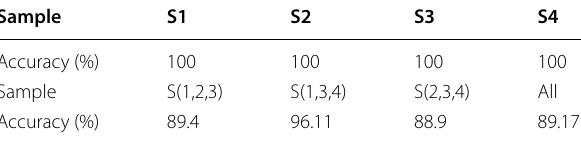
Table 4 Test results of each sample set (case 2)